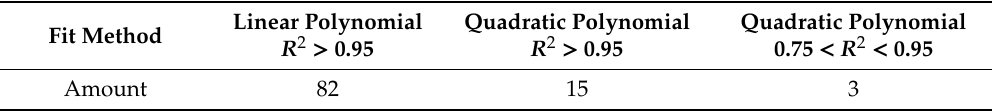
Table 4. Result of the edge